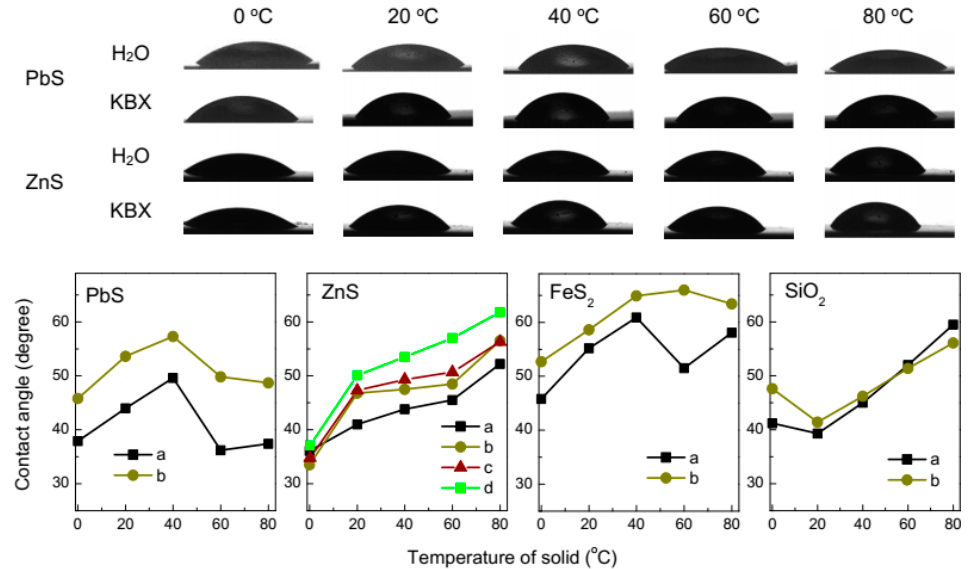
Figure 3. Upper panels: examples of sessile water drops cooled to 0.2 °C at galena and sphalerite plates kept at various temperatures. Lower panels: contact angles measured on the surfaces of PbS, sphalerite (ZnS), FeS 2 and SiO 2 (oxidized Si) plates as a function of the temperature of solid: ( a ) rinsed with water and ( b ) reacted with 10 mM potassium n-butyl xanthate solution (KBX) for 10 min. ZnS was also preliminarily reacted with ( c ) 0.1 mM CuSO 4 solution and then with 10 mM KBX ( d ).